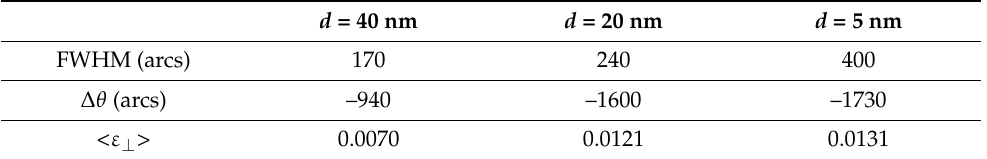
Table 1. XRD data including the FWHM and ∆ θ for the zero-order satellite peak, and the average perpendicular strain < ε ⊥ > for the triple-layer In 0.75 Ga 0.25 As QDs of d = 40 nm, 20 nm, and 5 nm. d = 40 nm d = 20 nm d = 5 nm FWHM (arcs) 170 240 400 ∆ θ (arcs) –940 –1600 –1730 < ε ⊥ > 0.0070